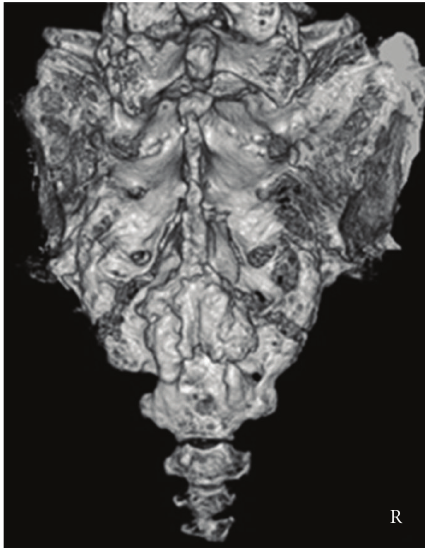
Figure 2: Preoperative three-dimensional CT: fracture lines began at the center of lamina and extended bilaterally. fracture involved Zone II and III. In relevance to clinical symptoms, we diagnosed Denis Zone III sacral